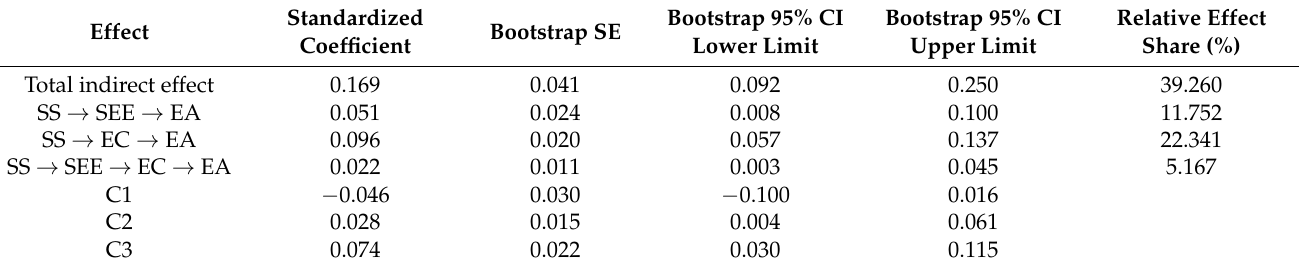
Table 4. Significance test results for differences in intermediate effects and effect